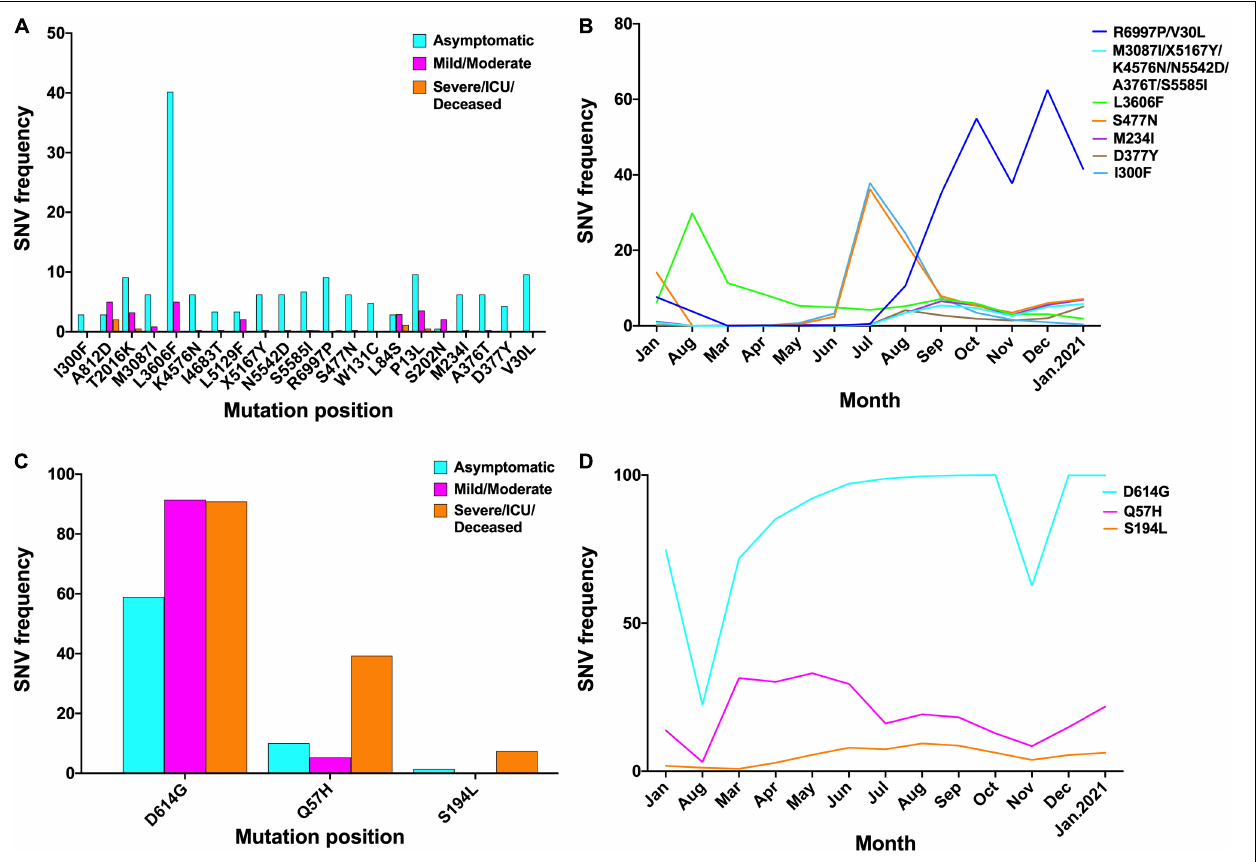
FIGURE 3 | Dynamics distribution of major symptom-associated mutations. (A) Mutation sites in asymptomatic cases that were higher than those in symptomatic cases, p < 0.05. (B) Major SNV frequency of (A) over time. (C) Mutation sites in symptomatic cases that were higher than those in asymptomatic cases, p < 0.05.